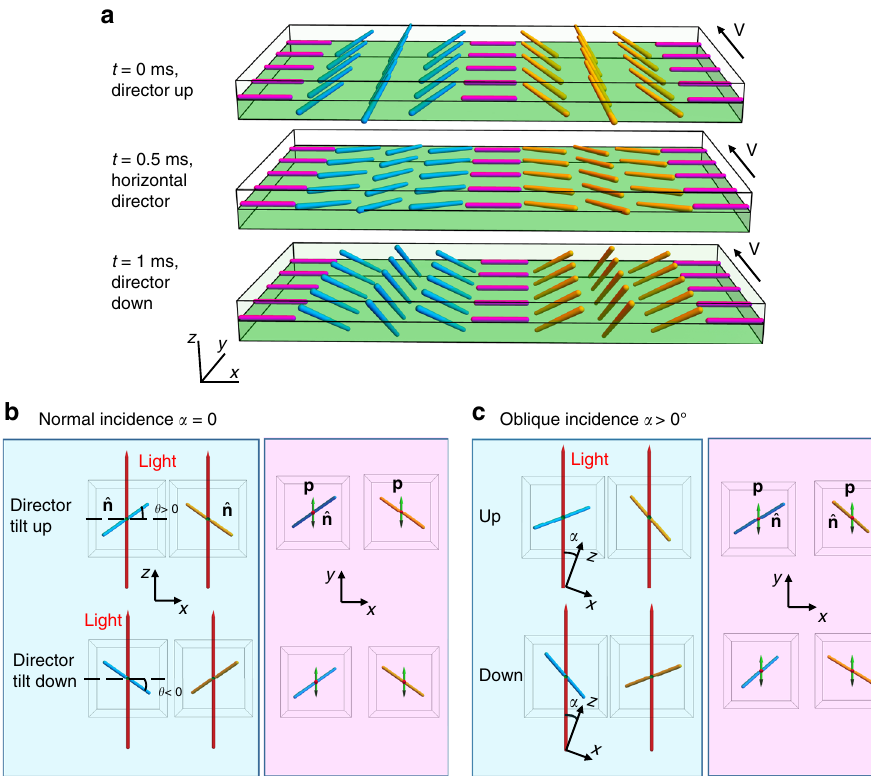
Fig. 4 Polar tilts of the director within the head of the soliton. a Scheme of the director. b Normal incidence of the light beam polarized along the y -axis; left and right parts of the soliton produce the same angle between light polarization ( p ) and the local director. c oblique incidence produces a different light transmittance through the left and right sides of the soliton because the angle between the local director and p is different in these two maximum | θ | ≈ 20° – 35° in the pixels labeled 1 and 2 in Fig. 1b. In pixels 1 and 2 in Fig. 1g show that θ oscillates with the same the rest of the tuxedo, i > 25 and pixel 3 in Fig. 1b, the light frequency f as the applied fi eld, Fig. 1h. There is a phase shift intensity does not oscillate, thus θ = 0, Fig. 1g. (about π /2) between E and θ . Namely, when the fi eld is zero, the To characterize the period and polarity of oscillations, we used light intensity reaches a minimum, Fig. 1g, which implies that | θ | oblique incidence, Fig. 4, with an angle α ≈ 14° measured in the reaches its maximum. The oscillations of θ do not change incidence xz plane between the probing light beam and the z -axis, Fig. 1a. This value of α represents the maximum tilt of a cell for a given distance to the microscope ’ s objective; smaller α ’ s yield a weaker contrast between the left and right sides of the tuxedo. For oblique incidence, the up and down tilts of the director, Fig. 4a, produce different projections onto the polarization direction of light (the y -axis), Fig. 4b, c. The light intensity variations for